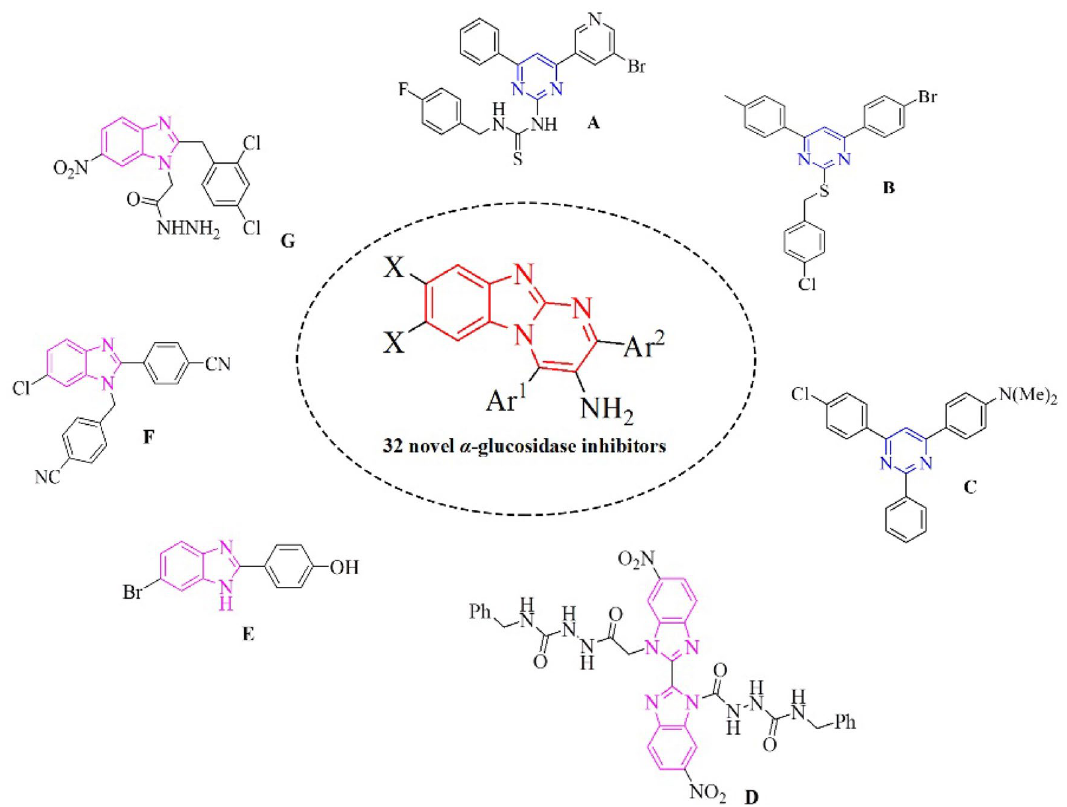
Figure 1. Design of new 3-amino-2,4-diarylbenzo[4,5]imidazo[1,2- a ]pyrimidine derivatives 3a-ag as novel α -glucosidase inhibitor. *This figure was drawn by ChemDraw Professional 16.0 (https:// perki nelmer- chemd raw- profe ssion al. softw are. infor mer.